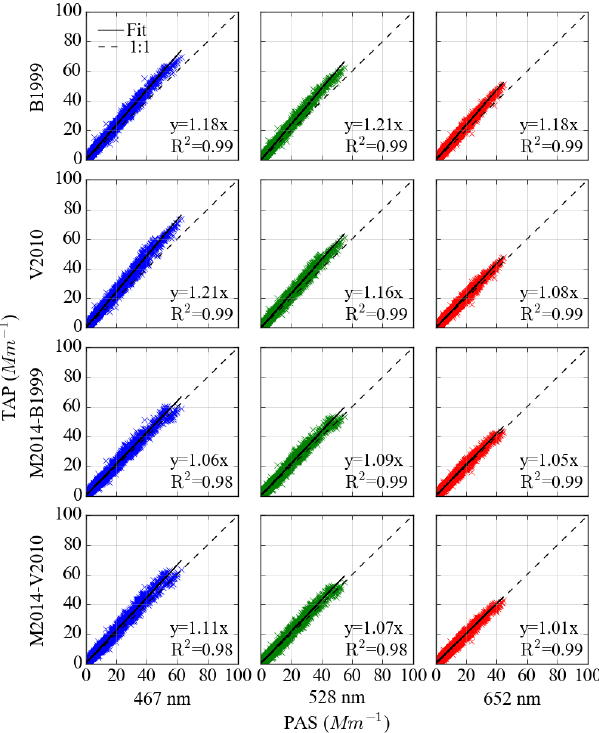
Figure 4. As Fig. 3 but for fresh biomass burning aerosol over Sene- gal in February and March 2017.